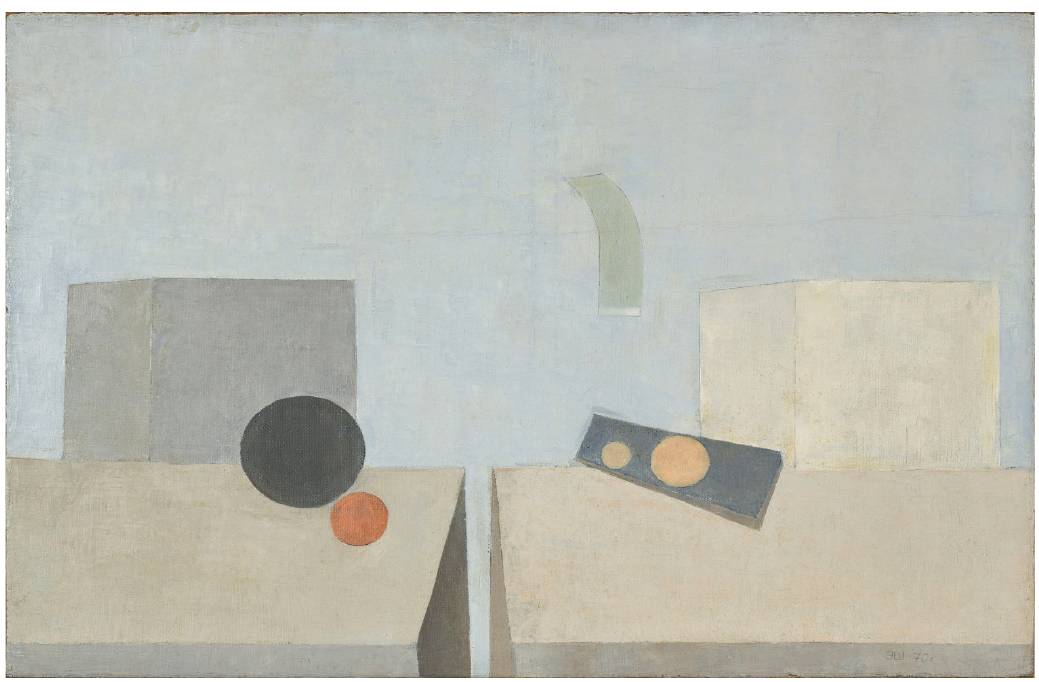
Figure 6. Eduard Steinberg. An abstract composition. February. 1970. Oils on canvas, 69.5 * 82.5 cm. Denis Khimilyaine’s collection. https://deniscollection.com/eduard-steinberg/composition-1975-5/ (accessed on 2 June 2022).